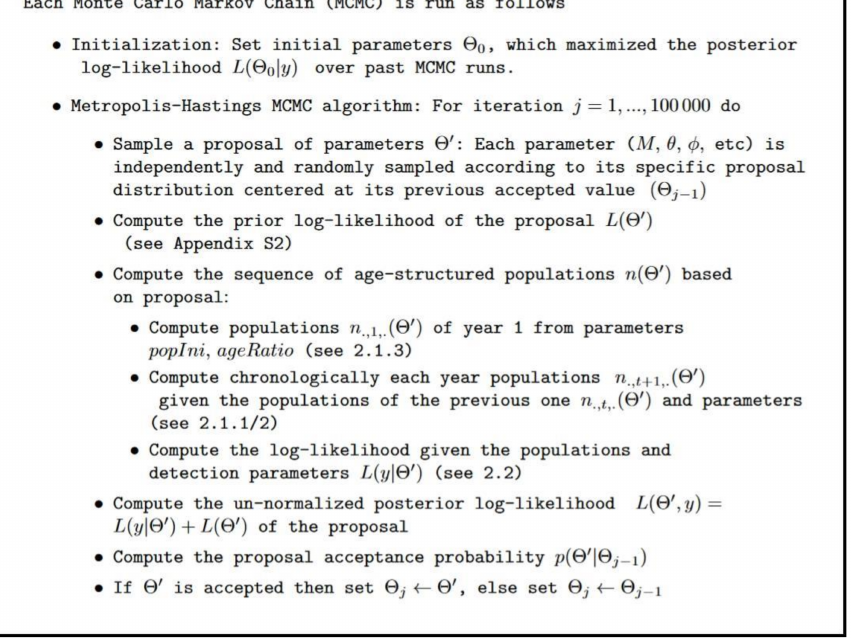
Figure 2. Summarized model fitting procedure for a single Monte Carlo Markov chain with Metropolis–Hastings sampling algorithm. The parameters Θ 0 included 48 parameters for the initial populations, 14 for the ecological process, and 3 for the sampling